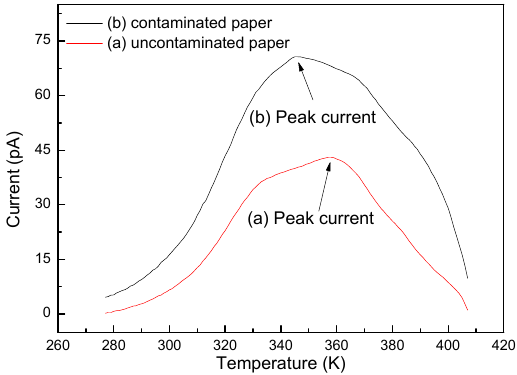
Figure 8. Thermally stimulated current (TSC) test results of two insulation paper samples: ( a ) uncontaminated paper; ( b ) contaminated